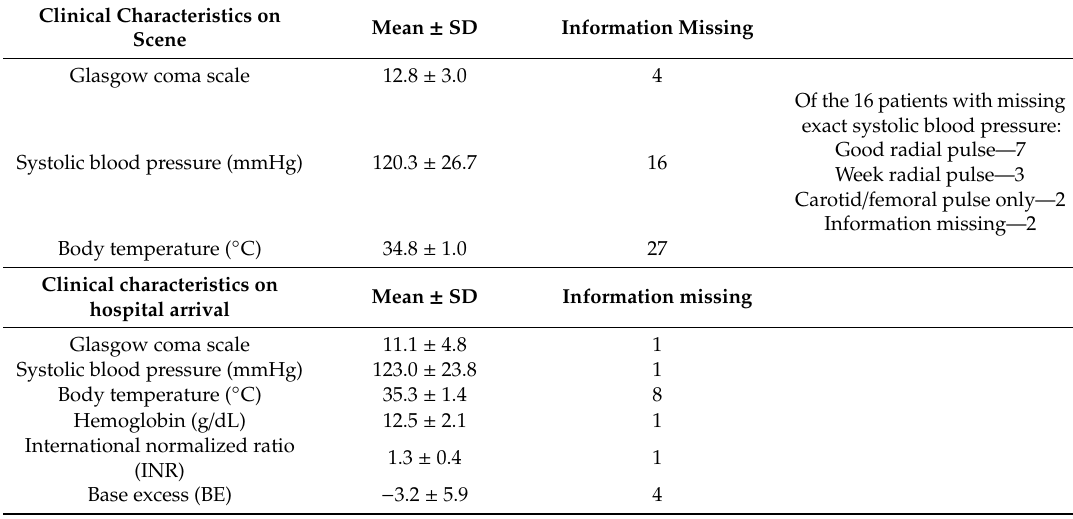
Table 1. Clinical characteristics on the scene and on hospital arrival plus selected laboratory values on hospital